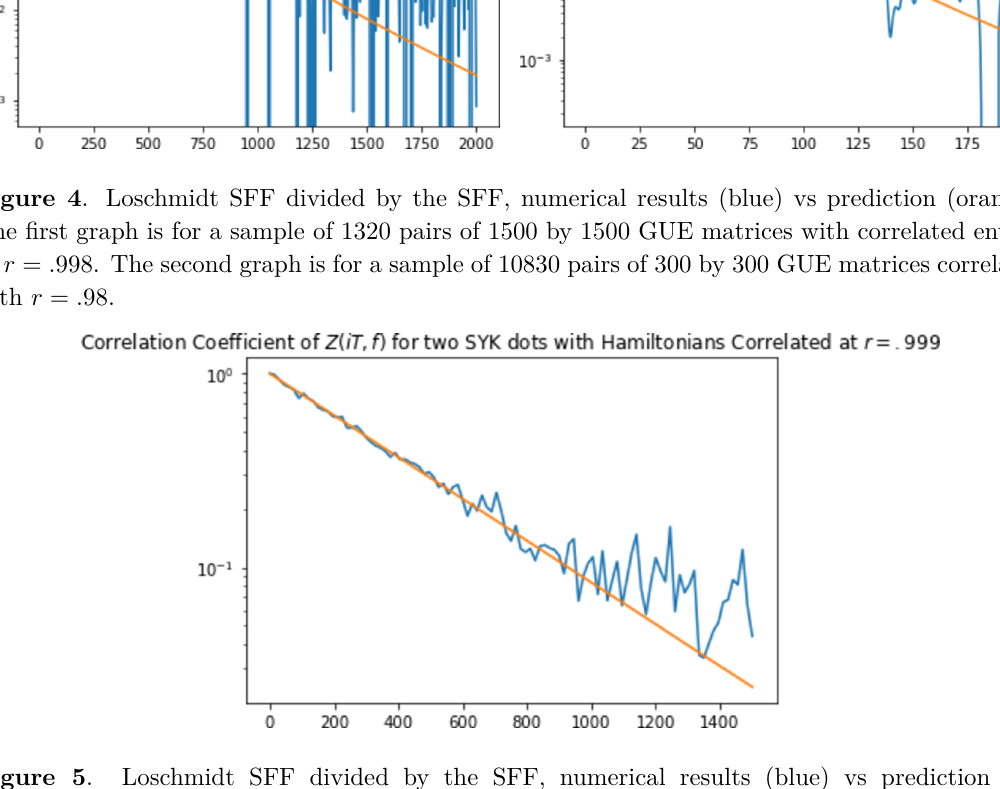
Figure 5 . Loschmidt SFF divided by the SFF, numerical results (blue) vs prediction (or- ange). These results are for two instances of the SYK model [40–42] with Hamiltonian H